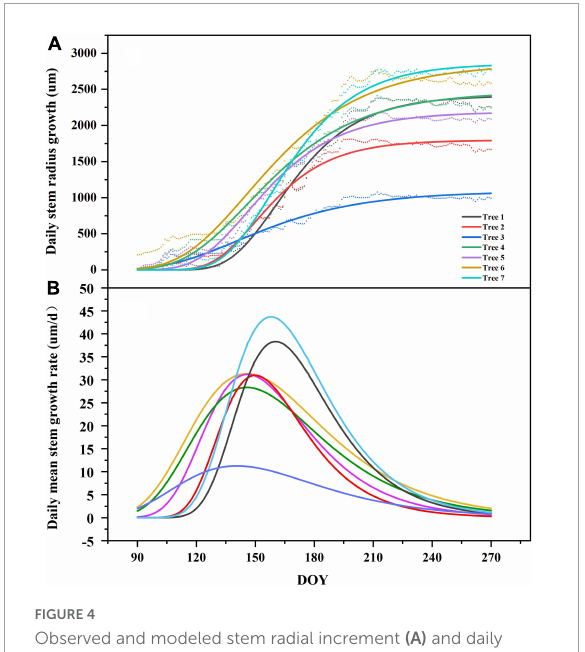
FIGURE4 Observed and modeled stem radial increment (A) and daily growth rates of seven L. principis-rupprechtii trees in 2021 (B) . The points and lines indicate the daily maximum radius and the original measurements of the sigmoid Gompertz function model curves.